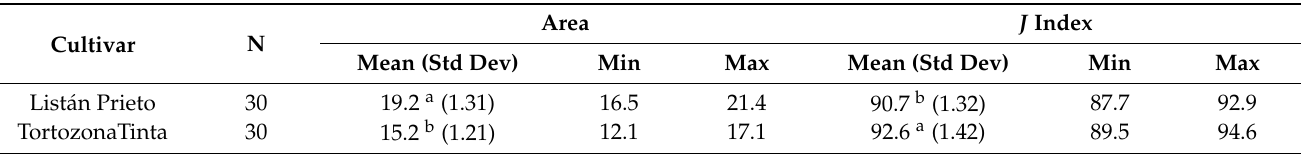
Table 3. Values of area and J index in the cultivars of the List á n Prieto group. Superscript letters indicate the results of Scheff é test: the mean values marked with the same letter in the superindex of each column do not differ significantly at p < 0.05. N is the number of seeds analyzed.